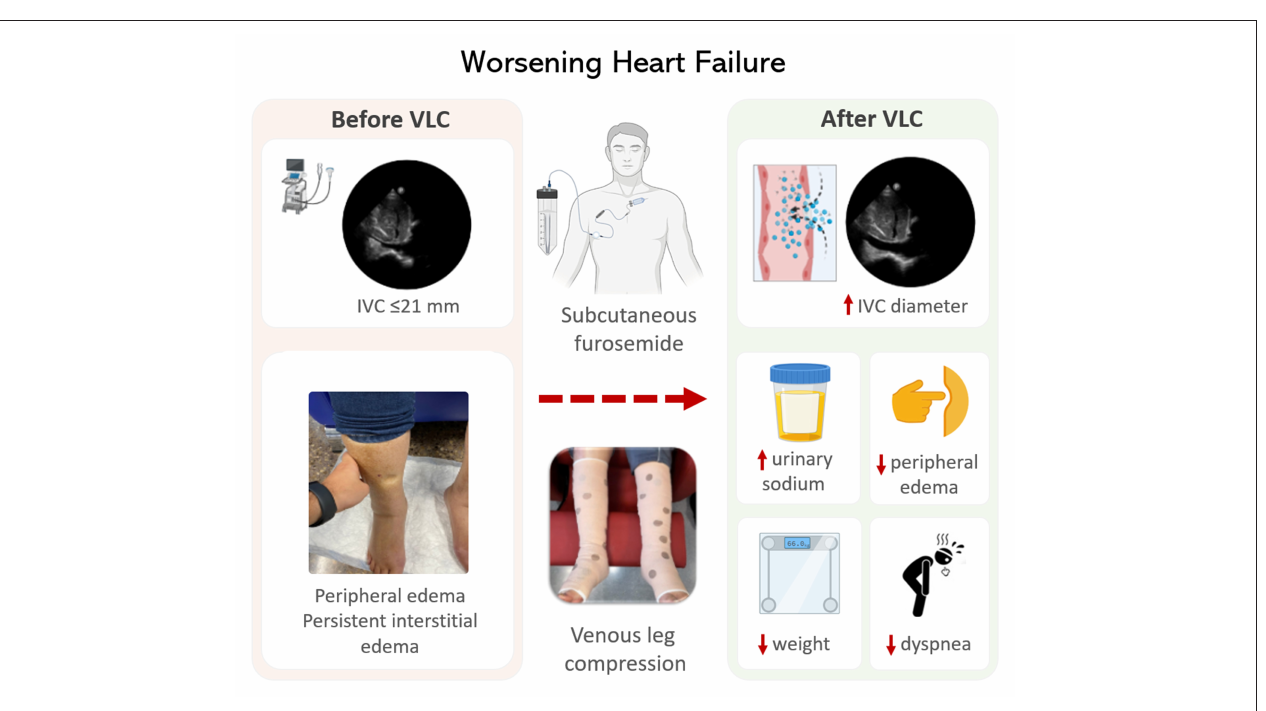
FIGURE 6 | Central illustration. The use of venous leg compression in congestive heart failure. IVC, inferior vena